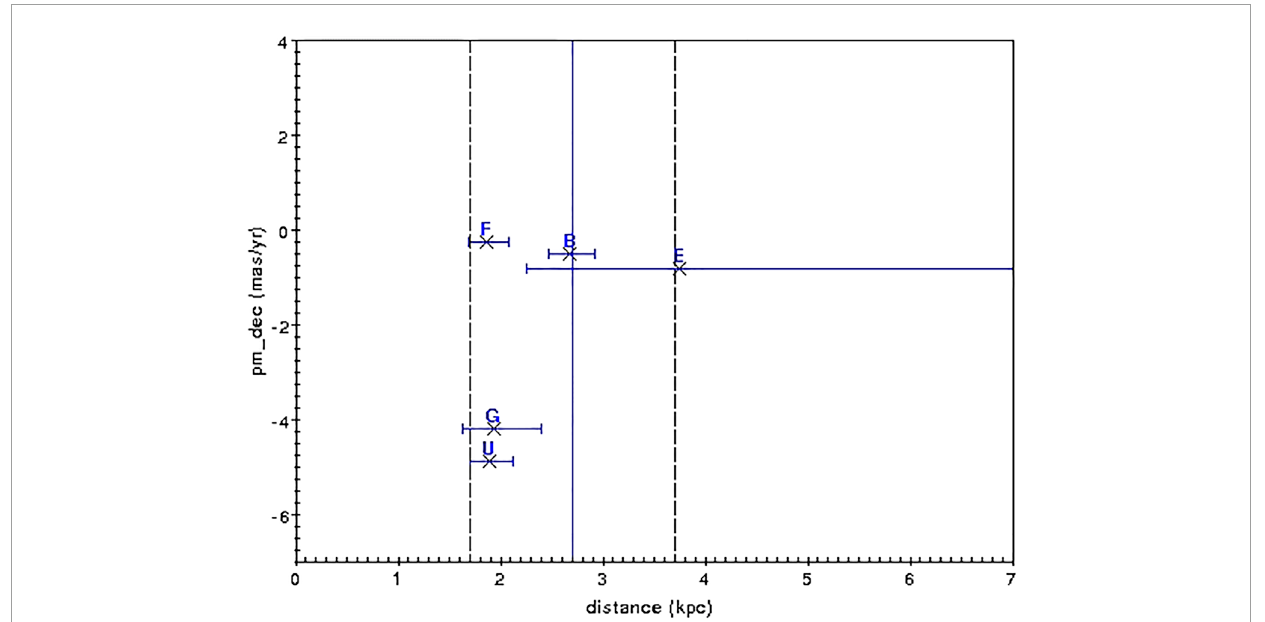
FIGURE A11 Distances and distance ranges inferred from the parallaxes in the Gaia DR3 and their uncertainties, together with their proper motions in declination. The dashed vertical lines mark the conservative limits of 2.7 ± 1 kpc on the distance to Tycho’s SNR. Solid (blue) error bars correspond to stars from Table 1 that, within reasonable uncertainties, might be inside the SNR. See for more stars Ruiz–Lapuente et al. (2019), since results have not changed